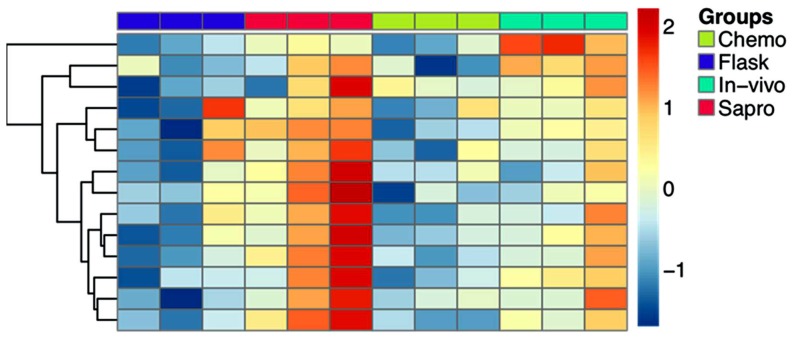
Expression profiles of the 14 genes in the ETP (epipolythiodioxopiperazines) secondary metabolite gene cluster.Relative expression values of individual replicates are shown. The expression level of each gene was normalized across all samples and is represented by a color whose intensity corresponds to the magnitude of deviation (σ) from the mean. The color-coded scale for normalized expression values maps is located at the right of the figure. Flask, replicates for A. flavus 3357 strain grown on CD medium; sapro, replicates for the A. flavus 3357 strain grown on dead maize kernels; chemo, replicates for the A. flavus 3357 strain grown in presence of injured viable maize kernels into the flask; in vivo, replicates for the A. flavus 3357 strain grown on the kernels into ears on the plant.